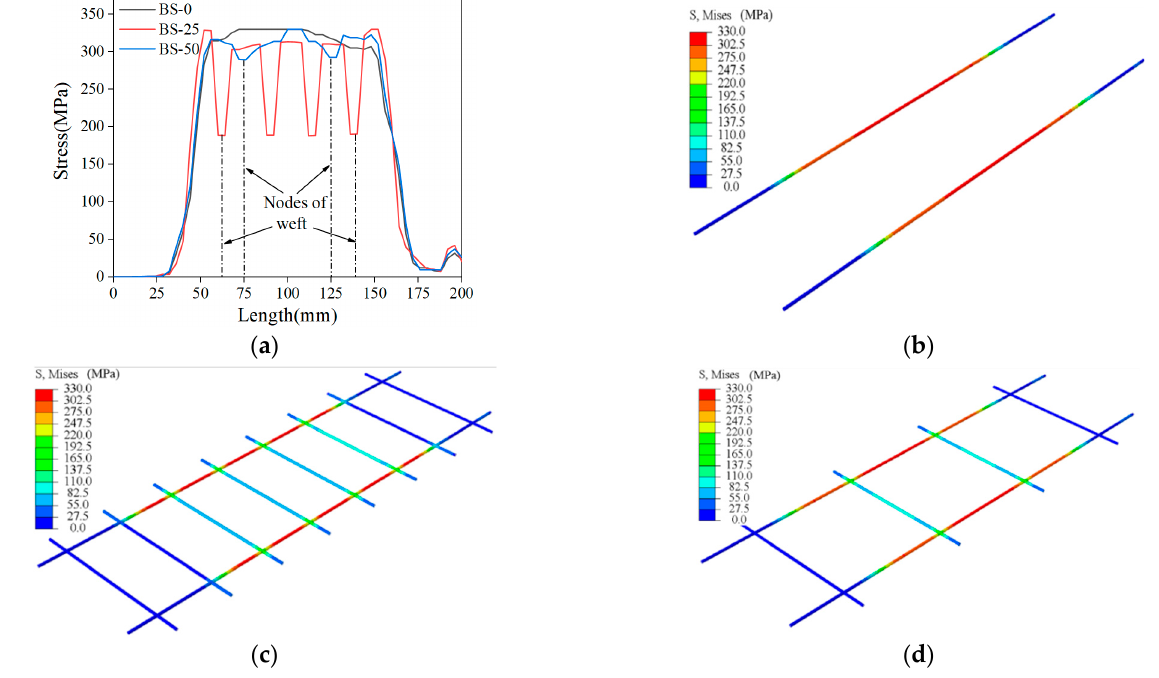
Figure 18. ( a ) Stress distribution pattern of weft yarn acting on the length direction of the specimen; ( b ) no weft yarn reinforcement, ( c ) grid weft yarn spacing of 25 mm, and ( d ) grid weft yarn spacing of 50 mm.